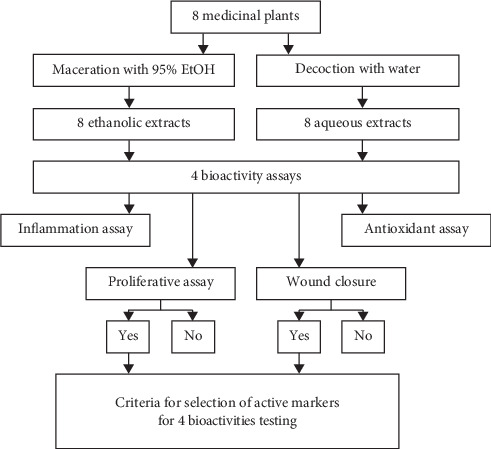
Flow chart of study.